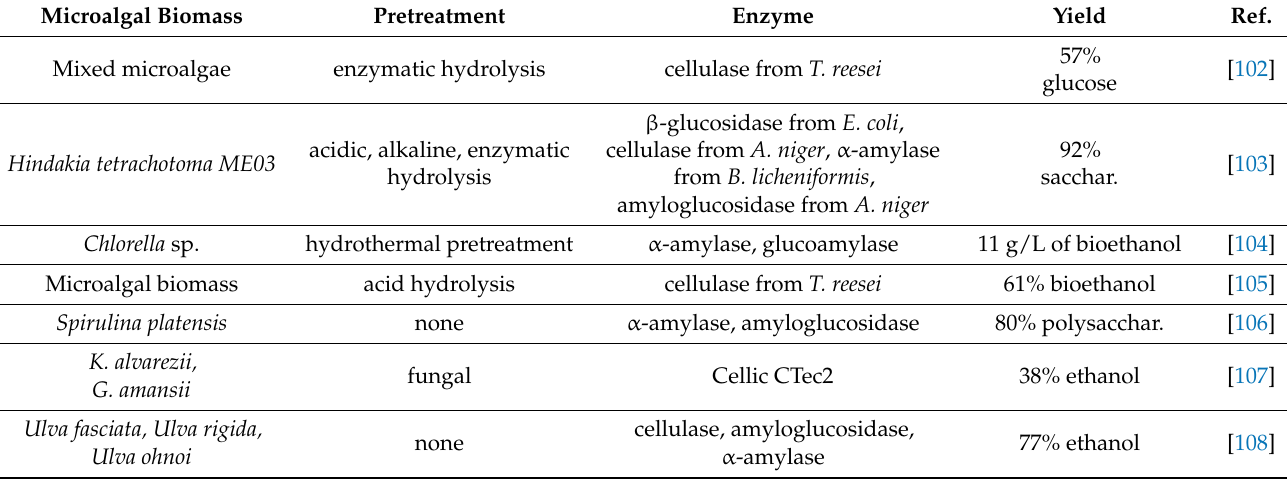
Table 2. Comparative chart for bioethanol production from marine